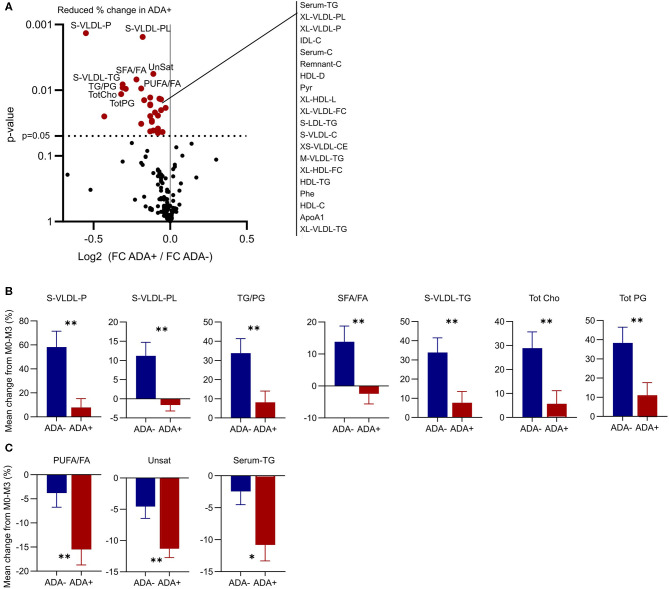
ADA– and ADA+ respond differently to IFN-β treatment. (A) Volcano plot to show differences in the metabolic response to IFN-β treatment between ADA+ and ADA–. The 10 metabolites with the most significantly different regulation are labeled, and the remainder with p < 0.05 are listed to the right. (B,C) The percentage change in the top 10 metabolites in ADA– (blue) and ADA+ (red) are shown as mean + SEM. Some metabolites were increased in ADA–, but not in ADA+ (B). Others were decreased in ADA– and ADA+, but by a greater magnitude in ADA+ (C). Un-paired t-test with Welch's correction for unequal variance; *p < 0.05, **p < 0.01.